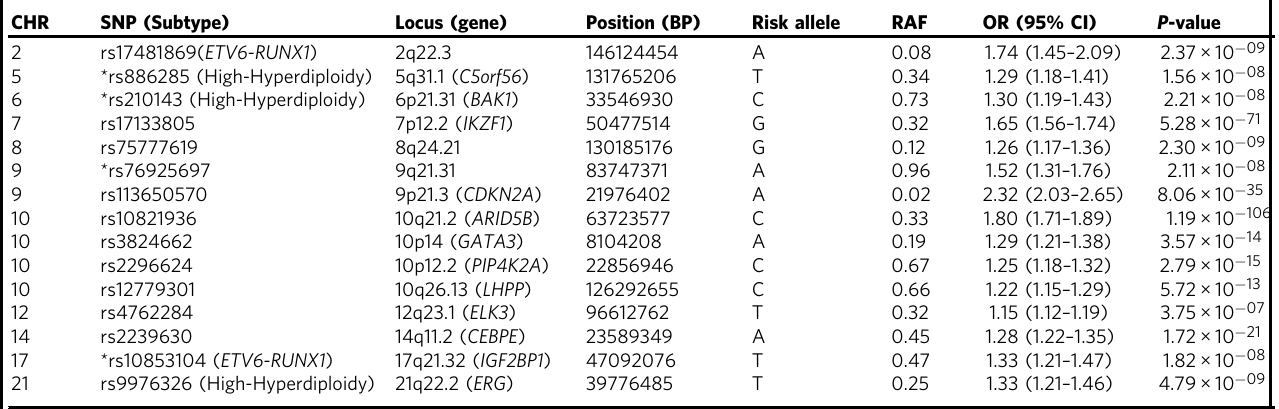
Table 1 Summary of results for genome-wide signi fi cant childhood ALL risk